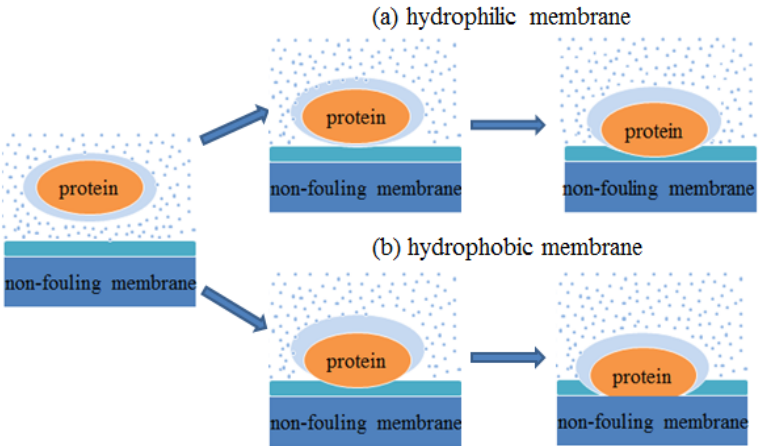
Figure 7. Antifouling mechanism. ( a ) Adsorption process of protein on hydrophilic membrane surface. ( b ) Adsorption process of protein on hydrophobic membrane surface.